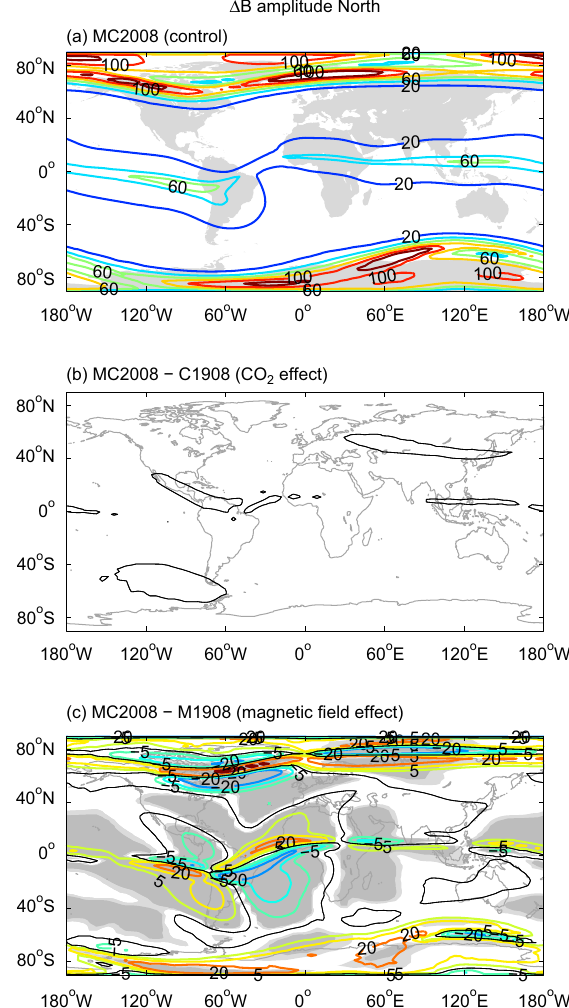
Fig. 4. Sixty-one-day mean daily amplitude of the northward magnetic perturbations for the control case (MC2008; panel a) and the difference with C1908 and M1908 (panels b/c). Contours for the difference plots are at 0, ±5, ±10, ±20, and ±50 nT. Light (dark) shading indicates statistical significance at the 95% (99%)